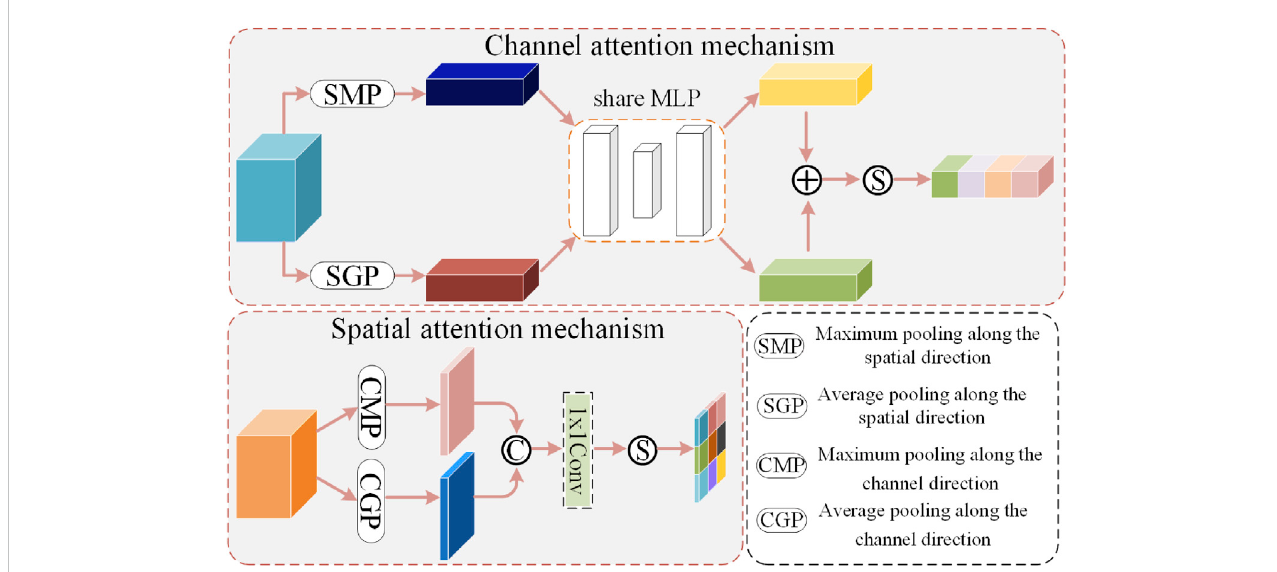
FIGURE 3 Network structure of channel attention and spatial